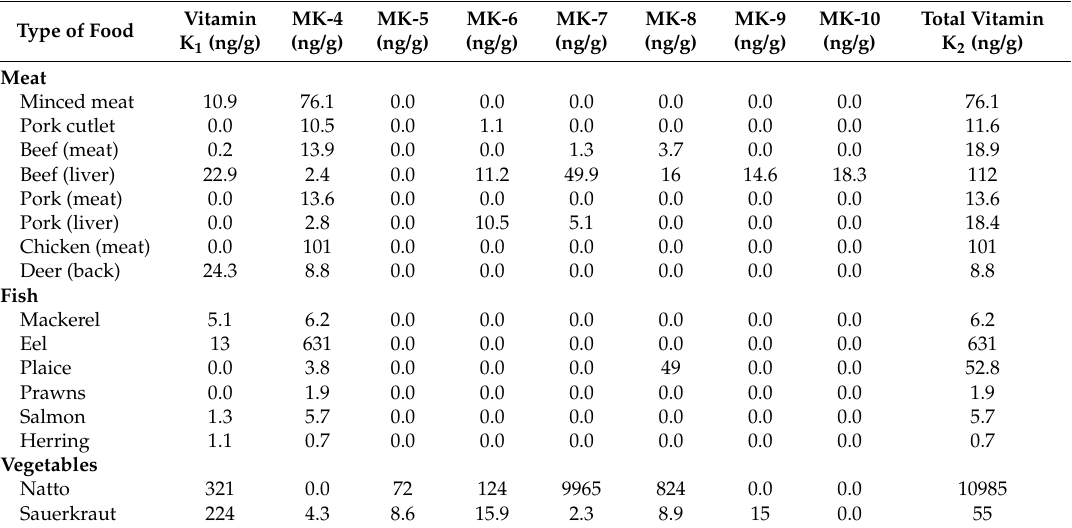
Table 3. Vitamin K content of non-dairy